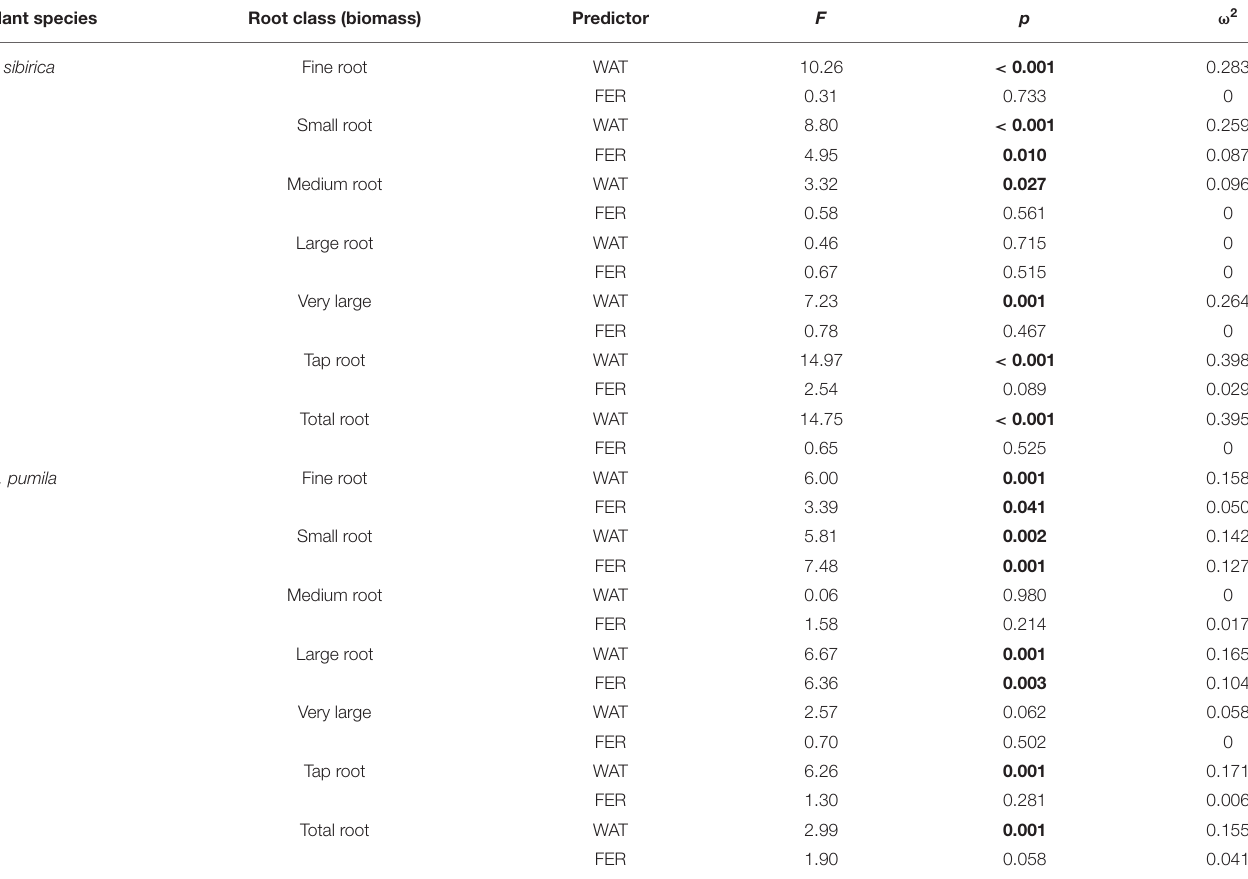
TABLE 3 | Two-way ANOVA results (predictors: WAT, water regime; FER, fertilization treatments) for biomass of each root diameter class. Plant species Root class